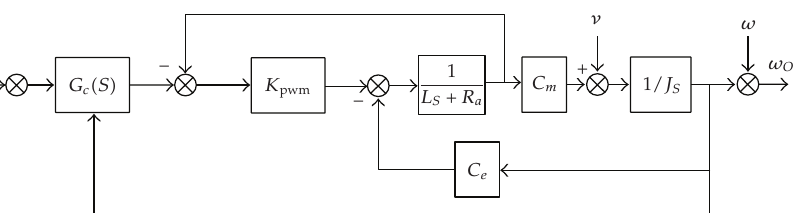
Figure 8: Block diagram of stabilization loop.